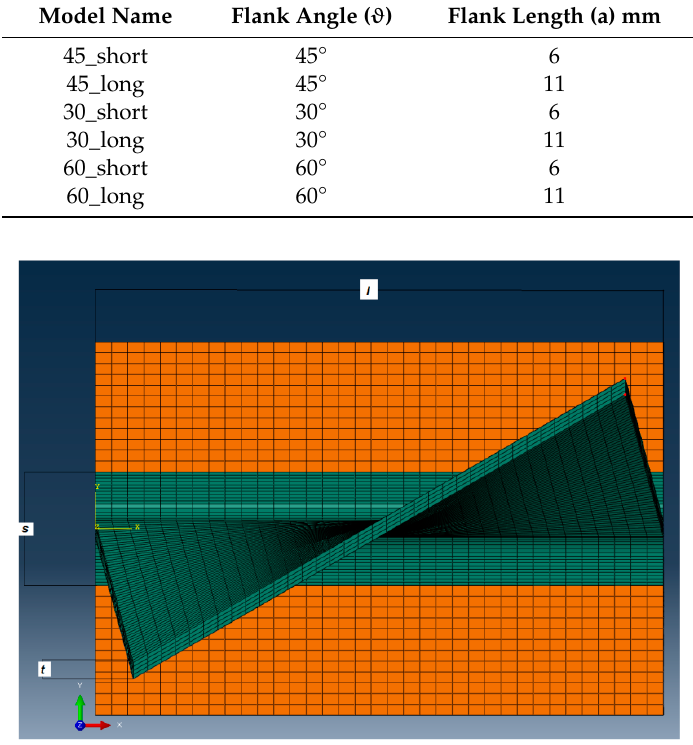
Figure 3. Non-variable dimensions in each of the six FE models.